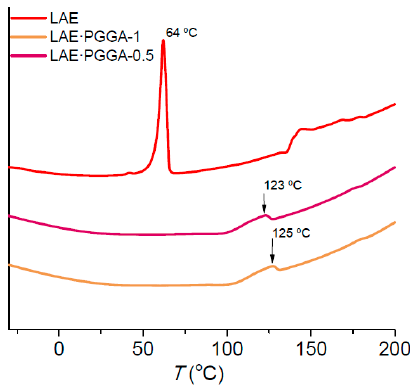
Figure 4. Differential scanning calorimetry (DSC) traces of LAE and its ionic complexes with PGGA.